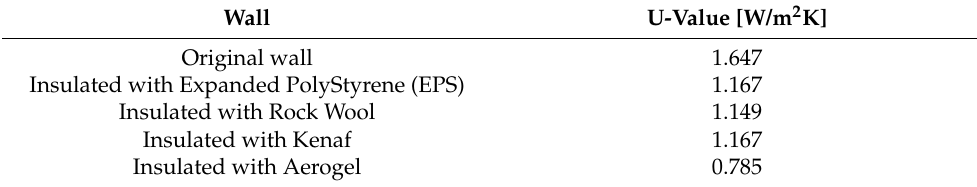
Table 4. U-Value of the Walls Considering Different Insulating